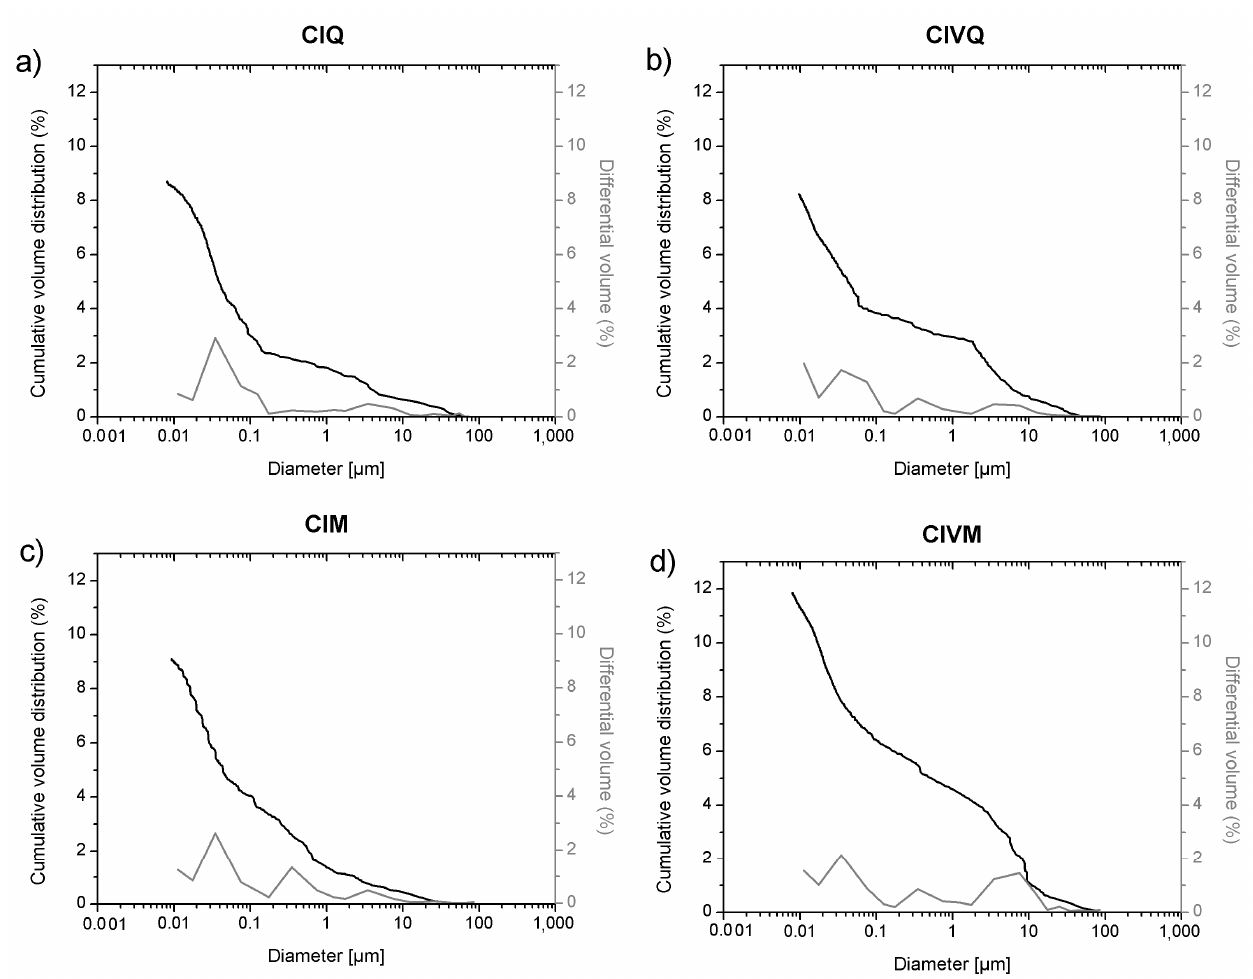
Figure 1. MIP cumulative volume distribution (black) and differential volume (gray) of samples ( a ) CIQ, ( b ) CIVQ, ( c ) CIM and ( d ) CIVM.